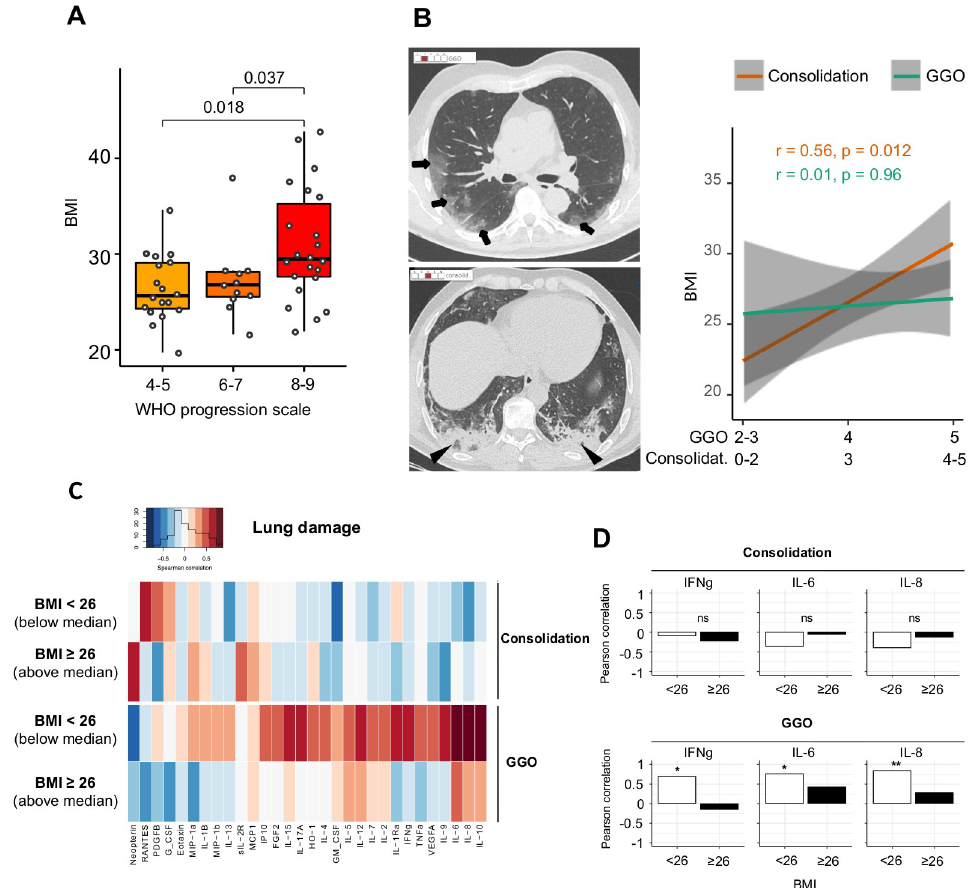
Fig 2. (A) Left part: box plots illustrating BMI in COVID-19 patients (n = 50) according to the level of respiratory distress (the WHO scale). Wilcoxon-Mann-Whitney test used for pairwise comparisons. (B) Left part: High-resolution axial computed tomography (CT) images of two patients show ground glass opacity (GGO; arrows) with a low score #2 and consolidation (arrowheads) with a moderate score #3. Right part: The correlations between the consolidation scale, GGO scale, and BMI. R for the Kendall rank correlation coefficient. (C) The Spearman correlation heatmap depicting the negative (blue), positive (red), and no (white) correlation between consolidation or the GGO extent evaluated based on chest CT images and the blood cytokines levels in COVID-19 patients (n = 19) according BMI below or above 26, i.e. the median BMI of patients with available CT (D) Bar plots showing the Spearman rank correlation coefficient of IFN γ , IL-6, and IL-8 with consolidation (top) or the GGO extent (bottom) according to the BMI levels (n = 19; � p < 0.05; �� p <